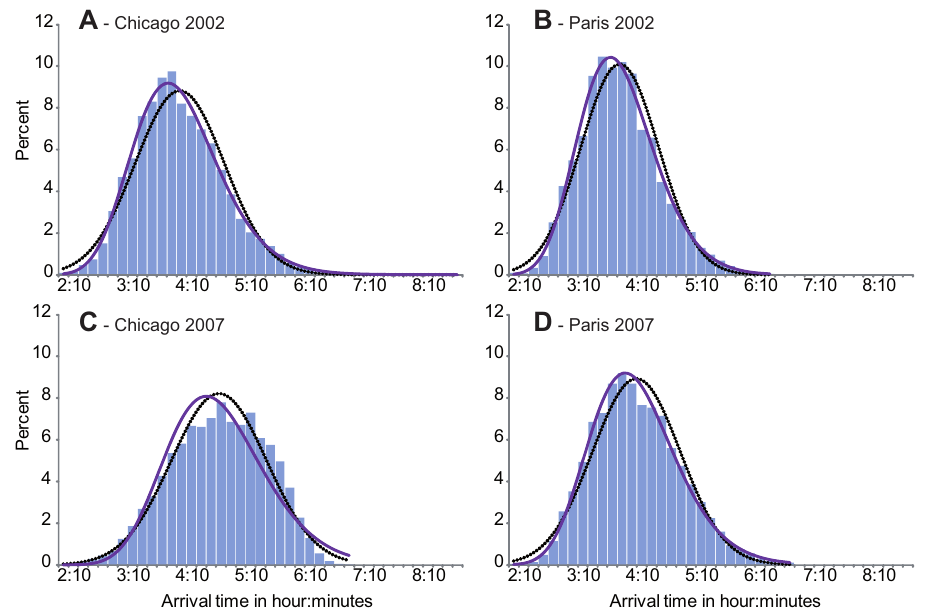
Figure 2. Distribution of performances: example of men’s performances distribution for Chicago (in 2002: T 6 C=5.4 6 C; and in 2007: T 6 C=25 6 C); and Paris (in 2002: T 6 C=7.6 6 C; and in 2007: T 6 C=17.4 6 C). doi:10.1371/journal.pone.0037407.g002 PLoS ONE |